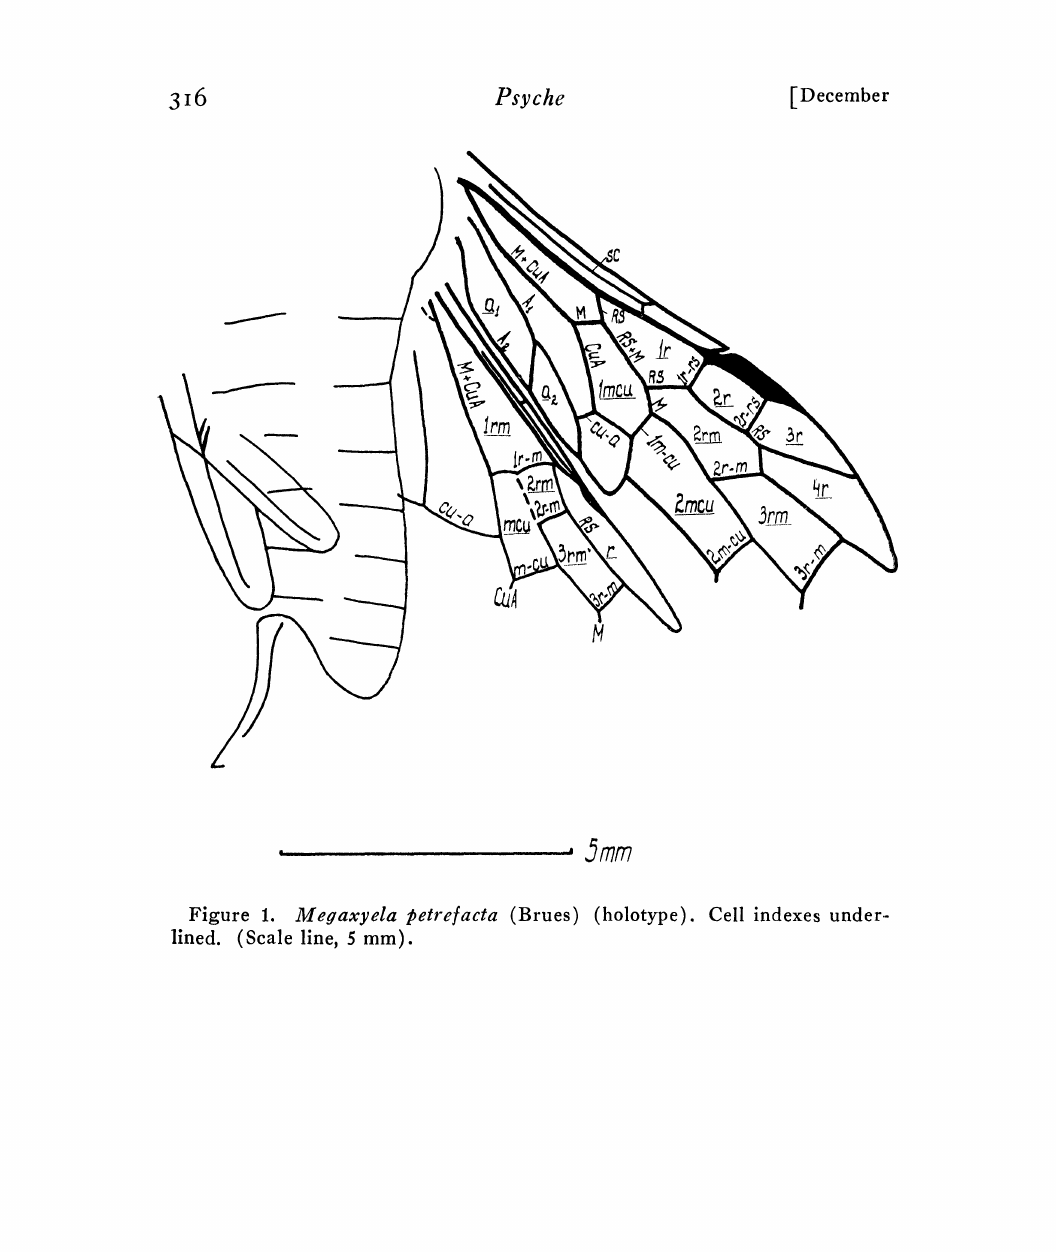
Figure 1. Megaxyela petre[acta (Brues) (holotype). Cell indexes under,- lined. (Scale line, 5